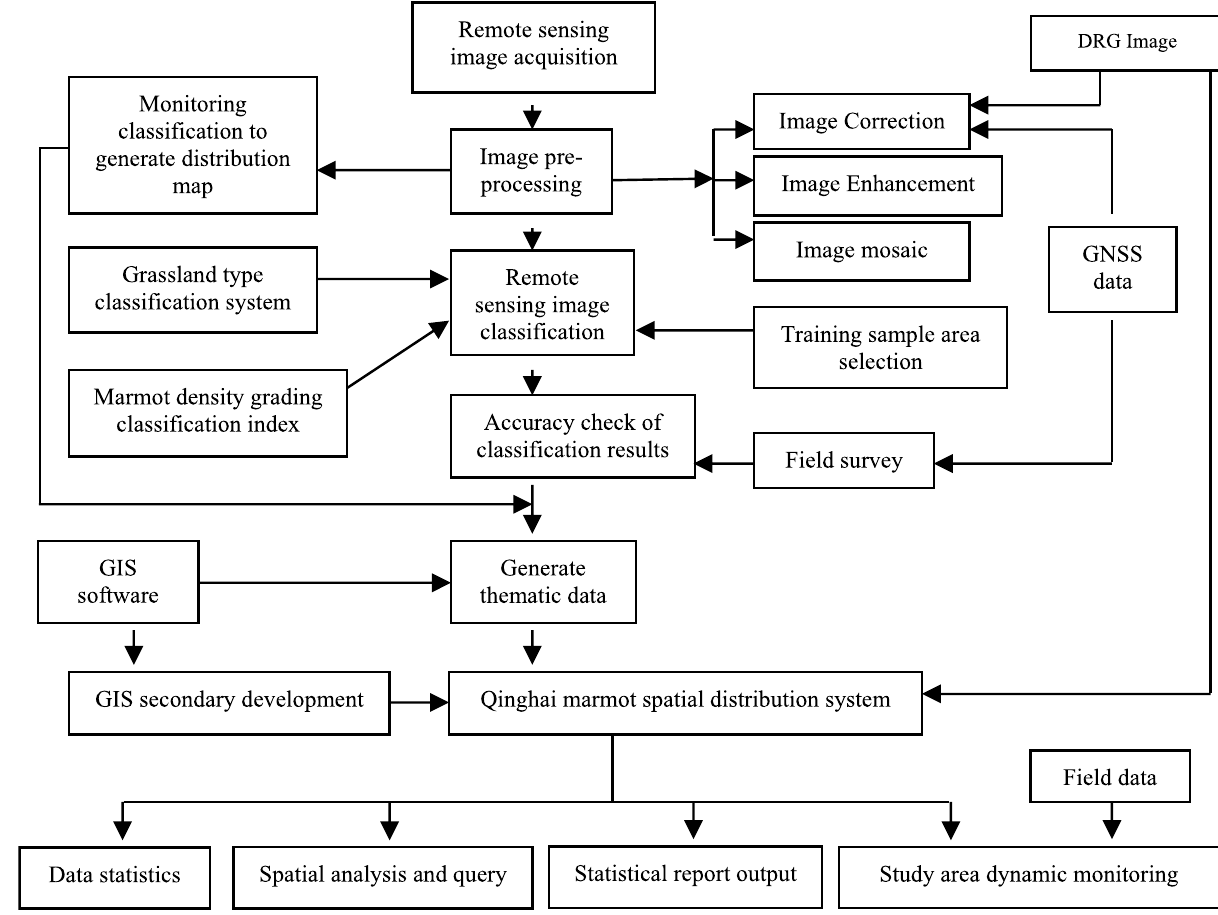
Figure 2. Schematic diagram of marmot information collection system V3.0 Data verification by field